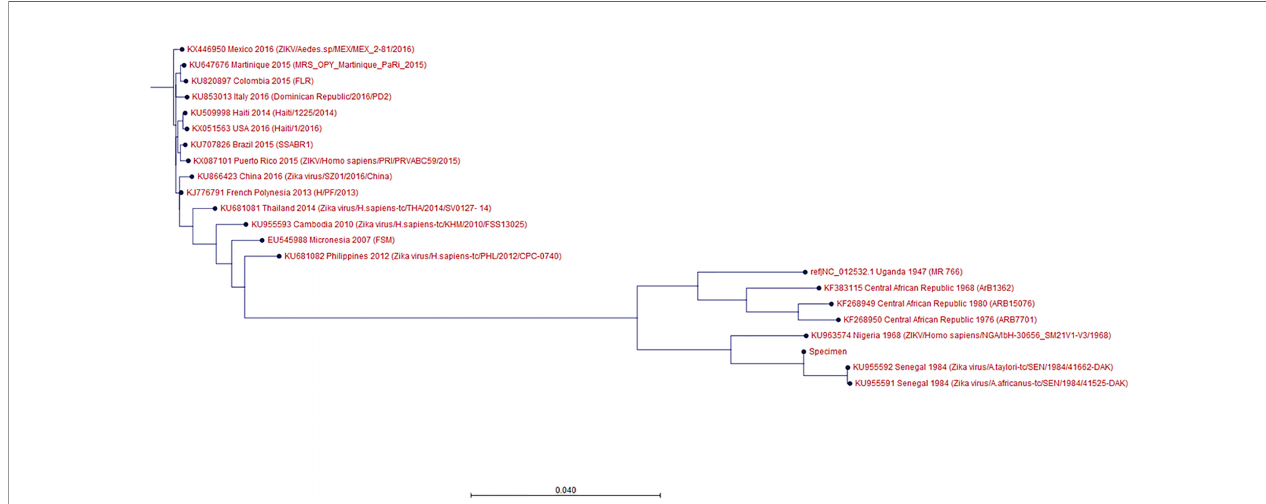
FIGURE 1 | Phylogenetic tree showing the ZIKV strains and the specimen. Out of 31 ZIKV strains chosen, 17 are shown in this tree; the details are given in the following order: GenBank accession No., country, collection date, strain/isolate name. Maximum likelihood method was used to create the phylogenetic tree, and bootstrapping was conducted with the number of 100 replicates. ‘ Specimen ’ refers to the ZIKV derived from the patient ’ s specimen. KU955591, KX446950 are the strains from the patient ’ s vaccine lab. The specimen was most highly related to KU955591, followed by NC_012532.1 and